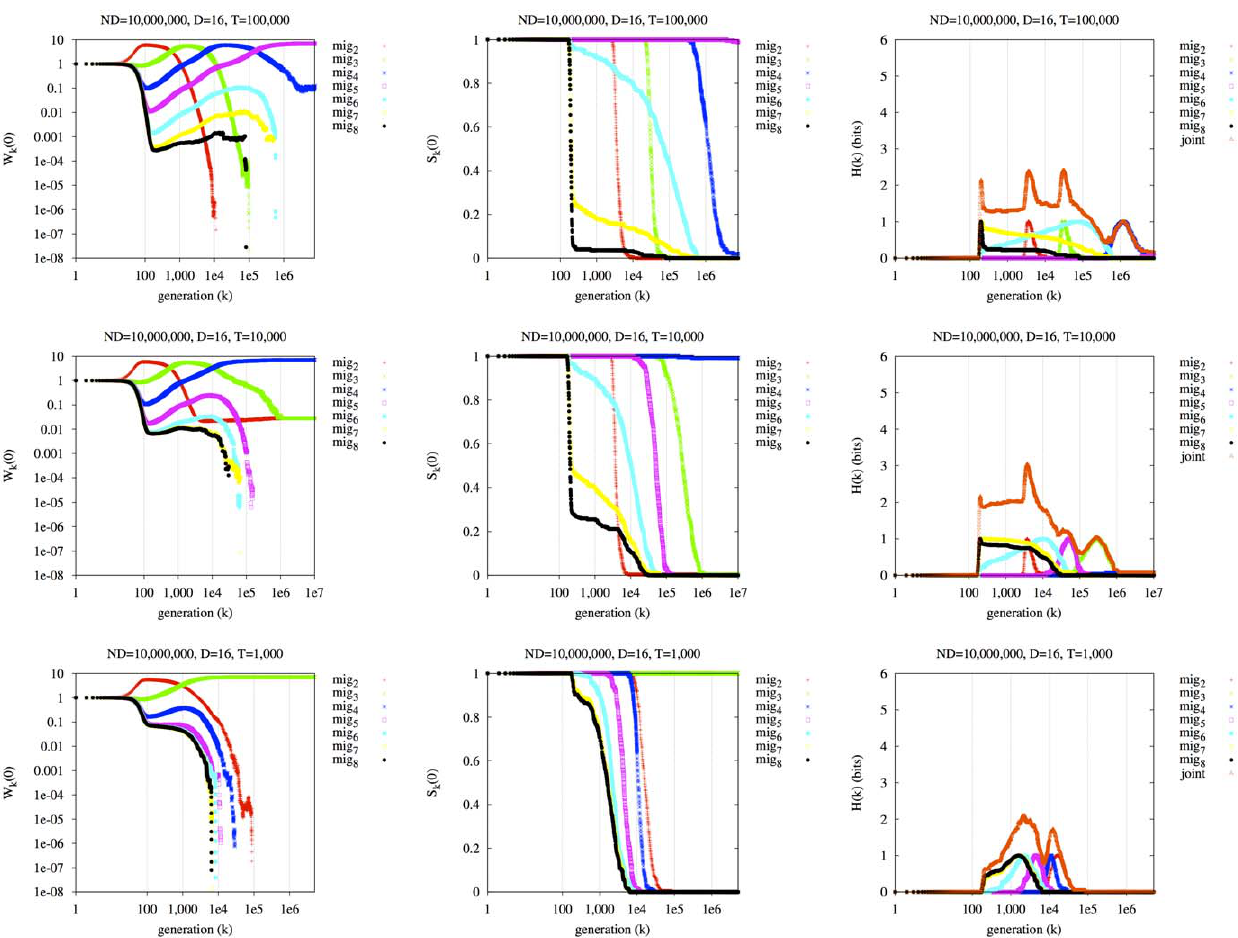
Figure 4. Effect of environmental switching on seven migrator lineages, mig 2 through mig 8 . In rows: three values of T ( T =100,000, 10,000, 1,000). Left column: W k 0 ð Þ . Middle column: S k 0 ð Þ . Right column: H k ð Þ . D=16 demes, total population ND =10,000,000. Mutation rate m =0.0.